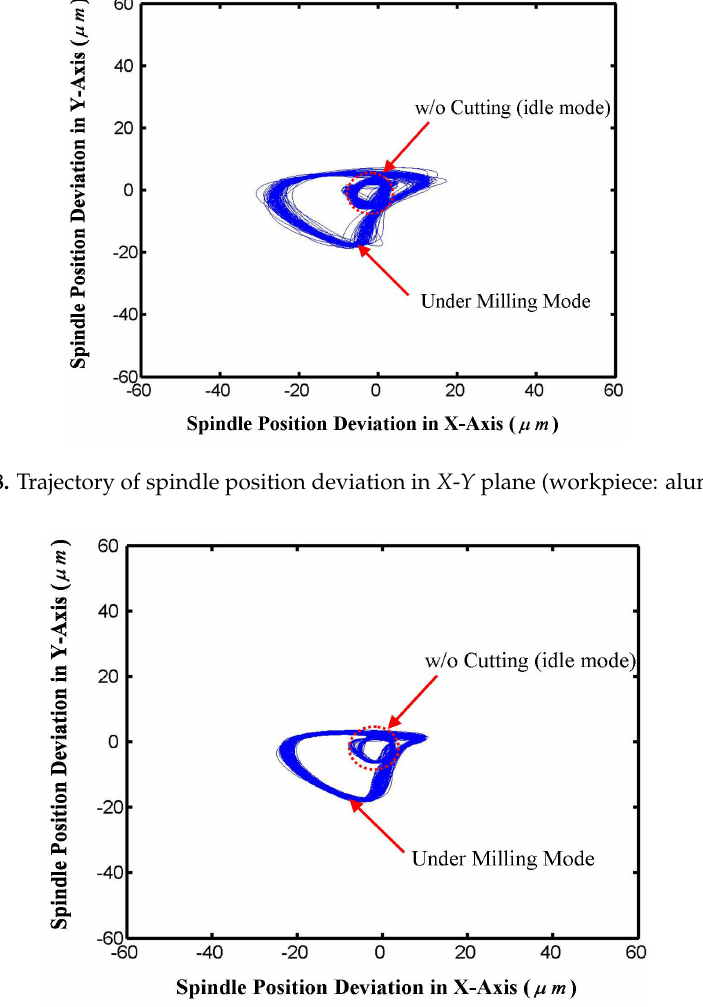
Appl. Sci. 2016 , 6 , 52 Figure 19. Trajectory of spindle position deviation in X - Y plane (workpiece: copper).